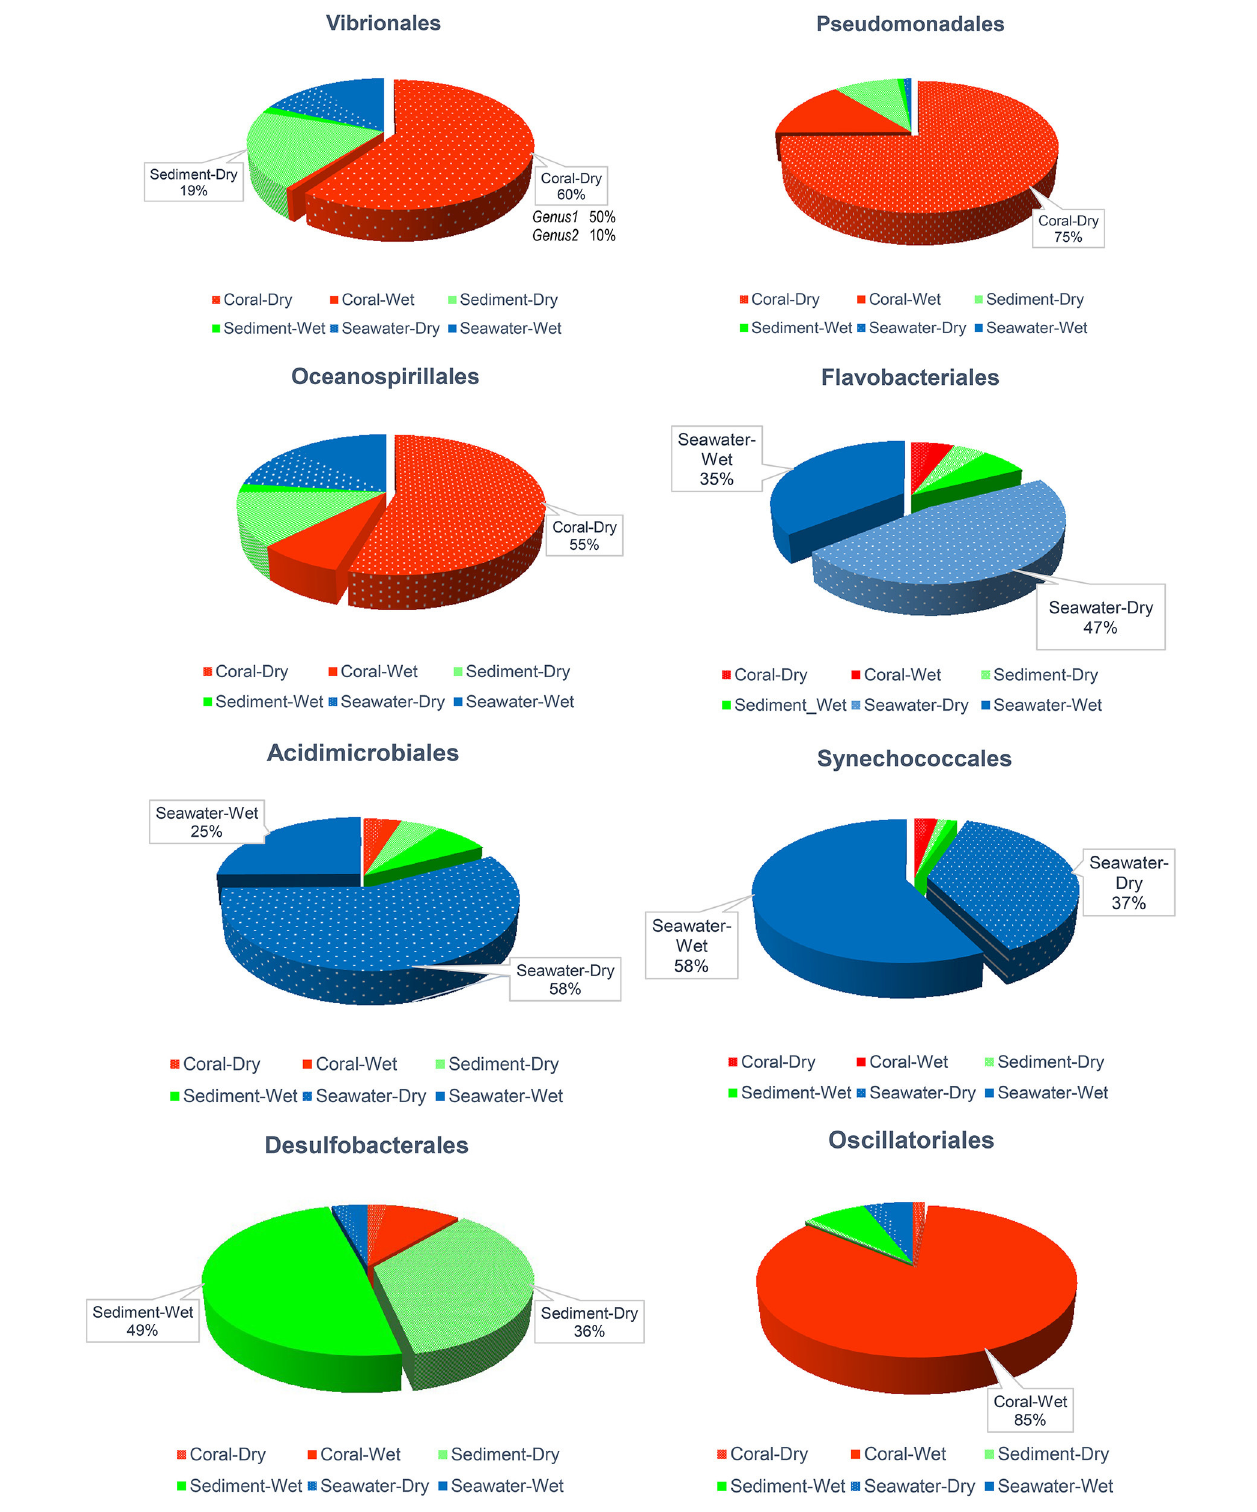
FIGURE 6 | Comparative abundance of Vibrionales, Pseudomonadales, Oceanospirillales, Flavobacteriales, Acidimicrobiales, Synechococcales, Desulfobacterales, and Oscillatoriales orders across sample types and seasons. Samples with ≤ 18% were omitted written percentages.